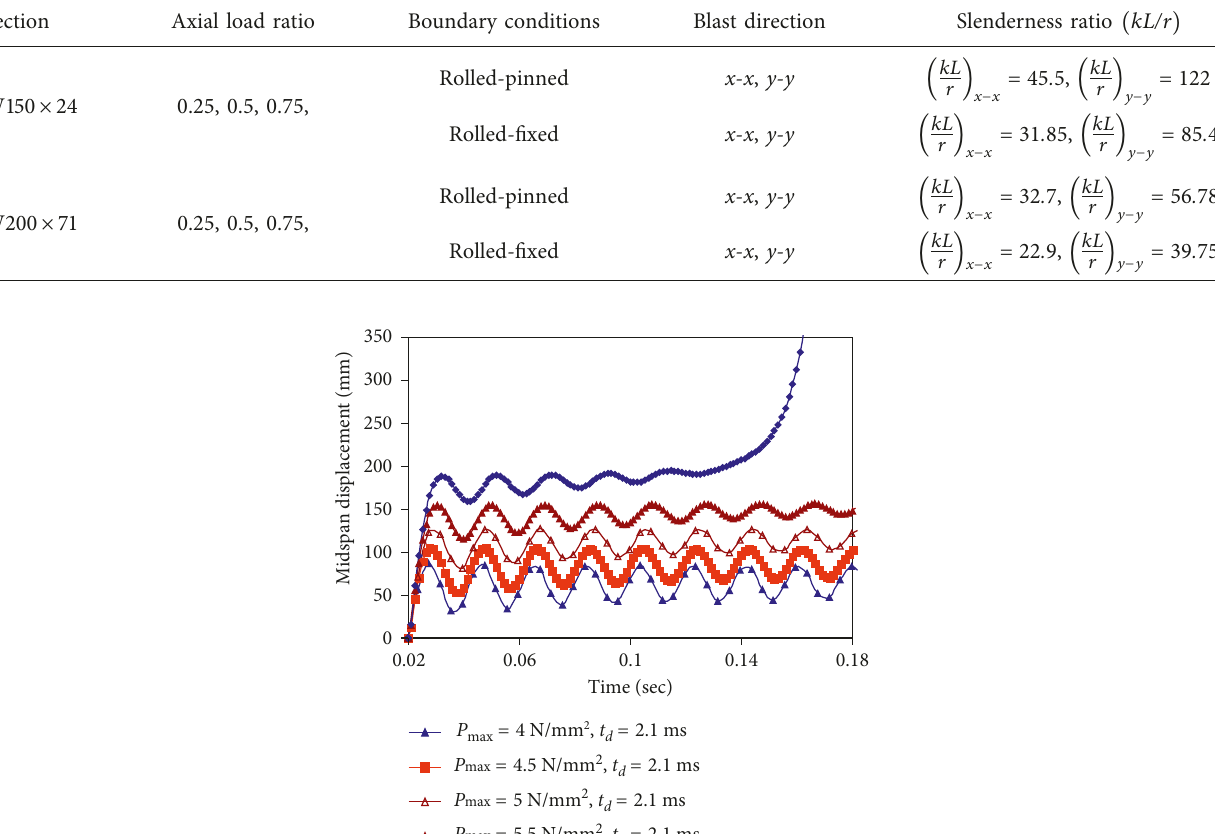
Table 3: The parameters used in the parametric study.